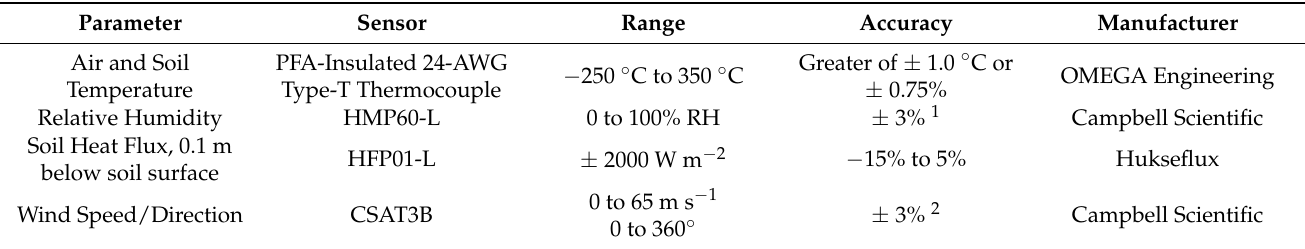
Figure 1. Dimensions of and sensor locations inside the experimental high tunnel: ( a ) end, ( b ) top, and ( c ) windward side view. T = air temperature and relative humidity; S = soil heat flux and soil temperature; R = solar radiation (LI200X); Q = PAR; W = wind speed and direction (W 1 = CSAT3B, W 2 = 034B-L, WS = Weather Station). Table 1. Sensors used to collect environmental data inside and outside the high